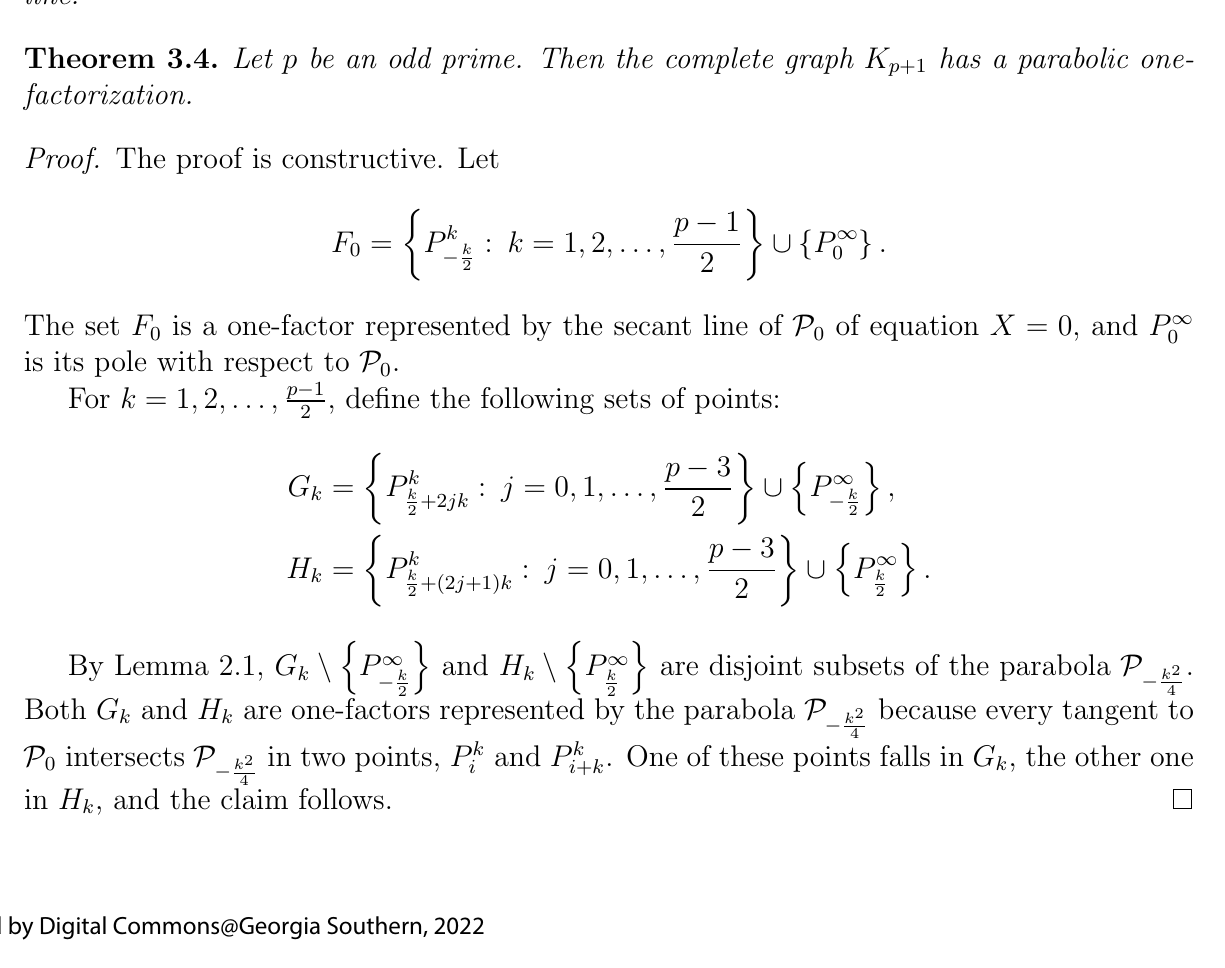
V of K on the parabola P i i + k p +1